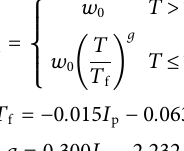
Table 1. More details of their databases and